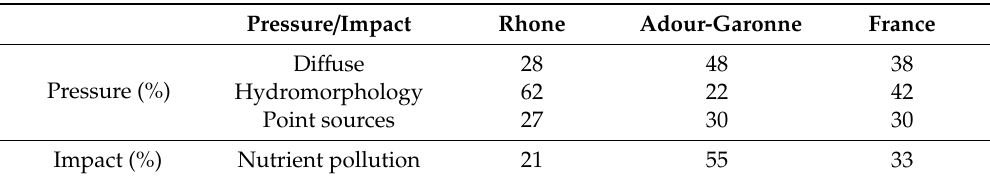
Table 1. Surface water bodies’ major pressures and impacts, as reported in the River Basin Management plans of the Rhone-Mediterranean-Corsica and the Adour-Garonne River Basin Districts, and for all of France [1].